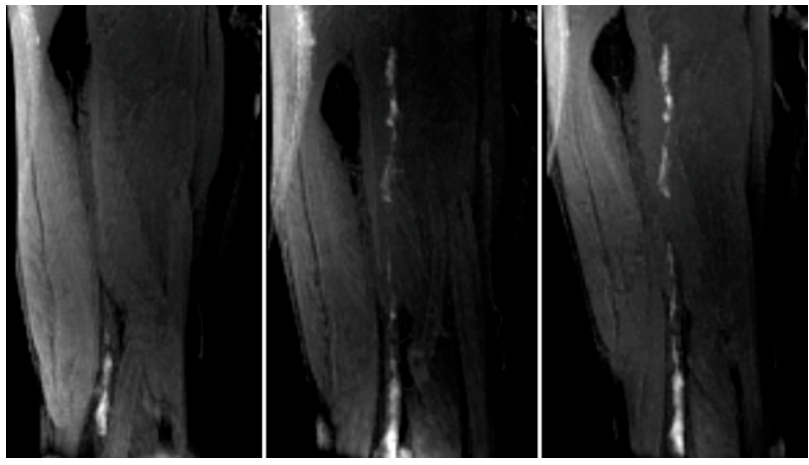
Figure 23. Left panel, met-Hb enhanced thrombus in the lower femoral / popliteal (knee) veins. Centre panel, Additional thrombus apparent in the mid and upper femoral vein when image acquired 2 h post EP-2104R injection. Right panel, 20 h postcontrast agent image demonstrates persistent enhancement of the thrombus. Reproduced with permission from Vymazal et al., 2009 [79].